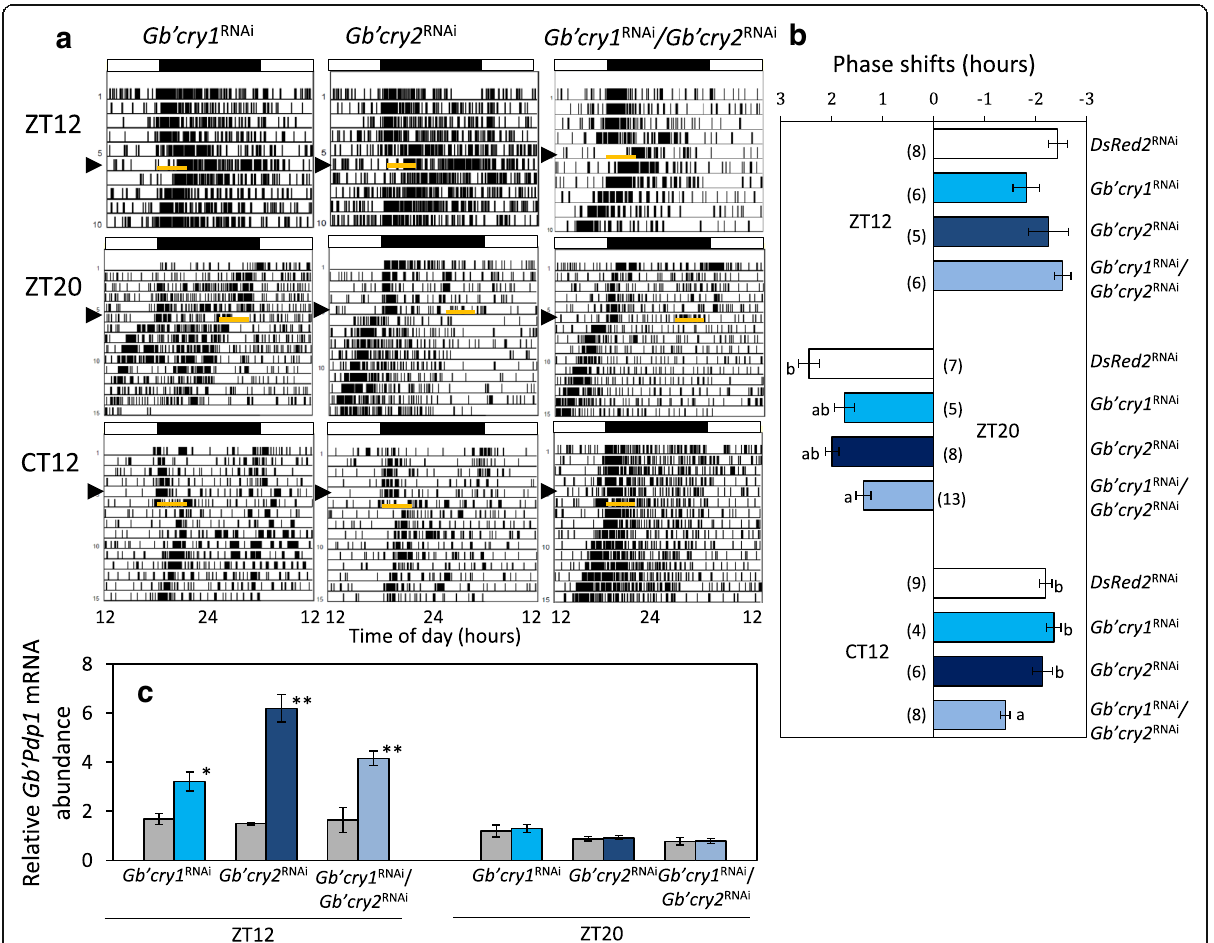
Fig. 2 Effects of RNAi of Gb ’ cry genes on light-induced phase shifts of circadian locomotor rhythm ( a , b ) and on light-induced Gb ’ Pdp1 expression ( c ) in the cricket Gryllus bimaculatus . a Phase shifts of locomotor rhythm caused by a 3 h light phase extension at ZT12 and a 3 h light exposure at ZT20 or CT12. Orange bars indicate a 3 h light phase extension or a light pulse. Black and white bars indicate dark and light phases, respectively. Arrow heads indicate the day of transfer to constant darkness. b Average phase shifts caused by a light phase extension at ZT12 or by a 3 h light pulse given at ZT20 or CT12. Error bars indicate SEM. Number in parenthesis indicates the number of crickets used. Different lower case letters indicate that values are significantly different (ANOVA followed by Tukey-Krammer test, P <0.05). c Effects of light exposure on Gb ’ Pdp1 mRNA levels at ZT12 or ZT20. Colored and grey bars indicate the results with and without 60 min light exposure, respectively. Light phase extension at ZT12 induced significant upregulation of Gb ’ Pdp1 expression (t-test, P <0.05) in all Gb ’ cry RNAi crickets, while light exposure at ZT20 had no